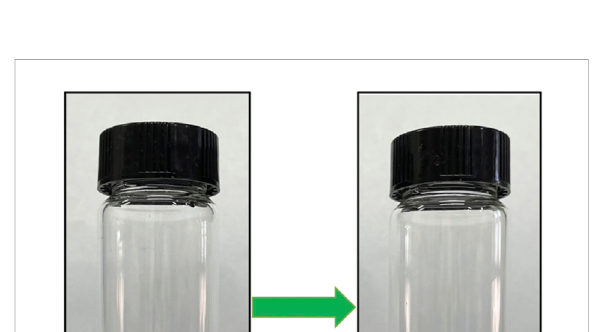
FIGURE 12 Different utilization methods for the CFRP delamination products.